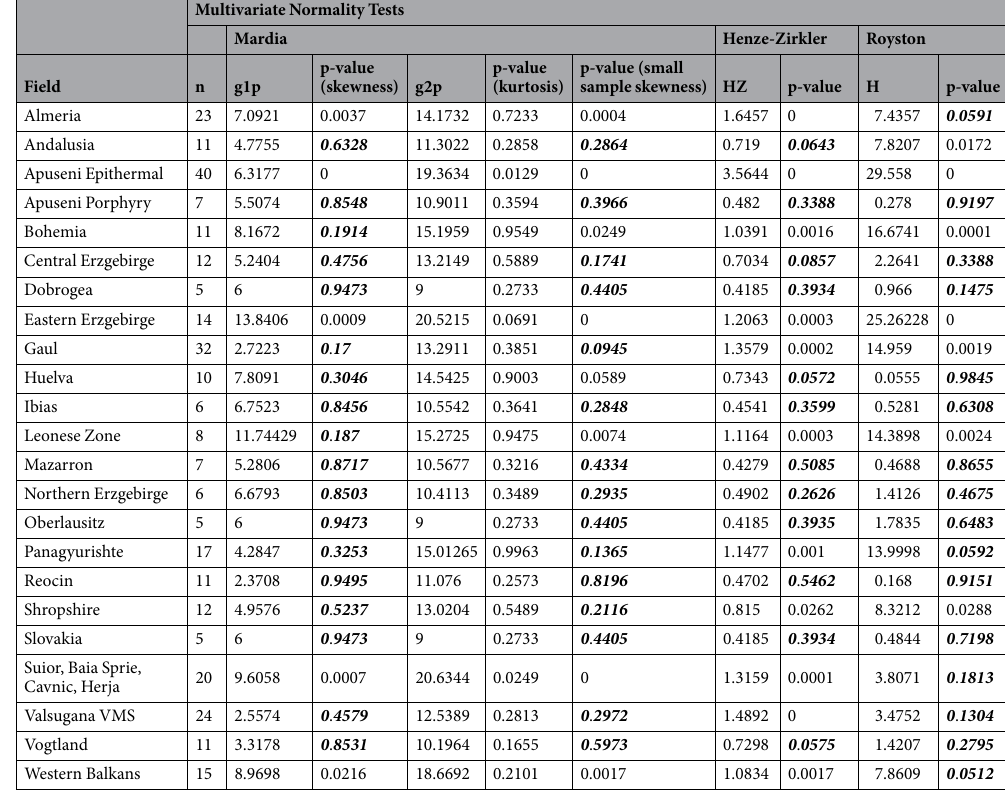
Table 2. Multivariate normality (MVN) tests results for each ore body mentioned in this work. Three tests (Mardia, Henze-Zirkler and Royston) are presented. For Mardia’s multivariate normal test, g1p is the statistic of skewness and g2p the statistic of kurtosis, and p-values indicate the significance of these values. Also presented is the p-value of small sample skewness, a further significance value, developed using empirical critical values for small sample sizes (n < 50 87 ). For both Henze-Zirkler and Royston tests only a single statistic is presented, HZ and H, respectively. All p-values significant at 5% are in bold and italicised, indicating multivariate normal distribution for that ore